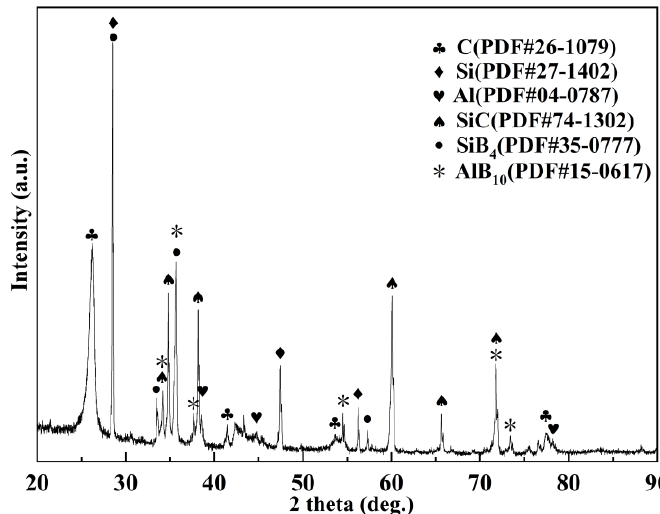
Figure 5. XRD patterns of the AlSiB-C/C composites before